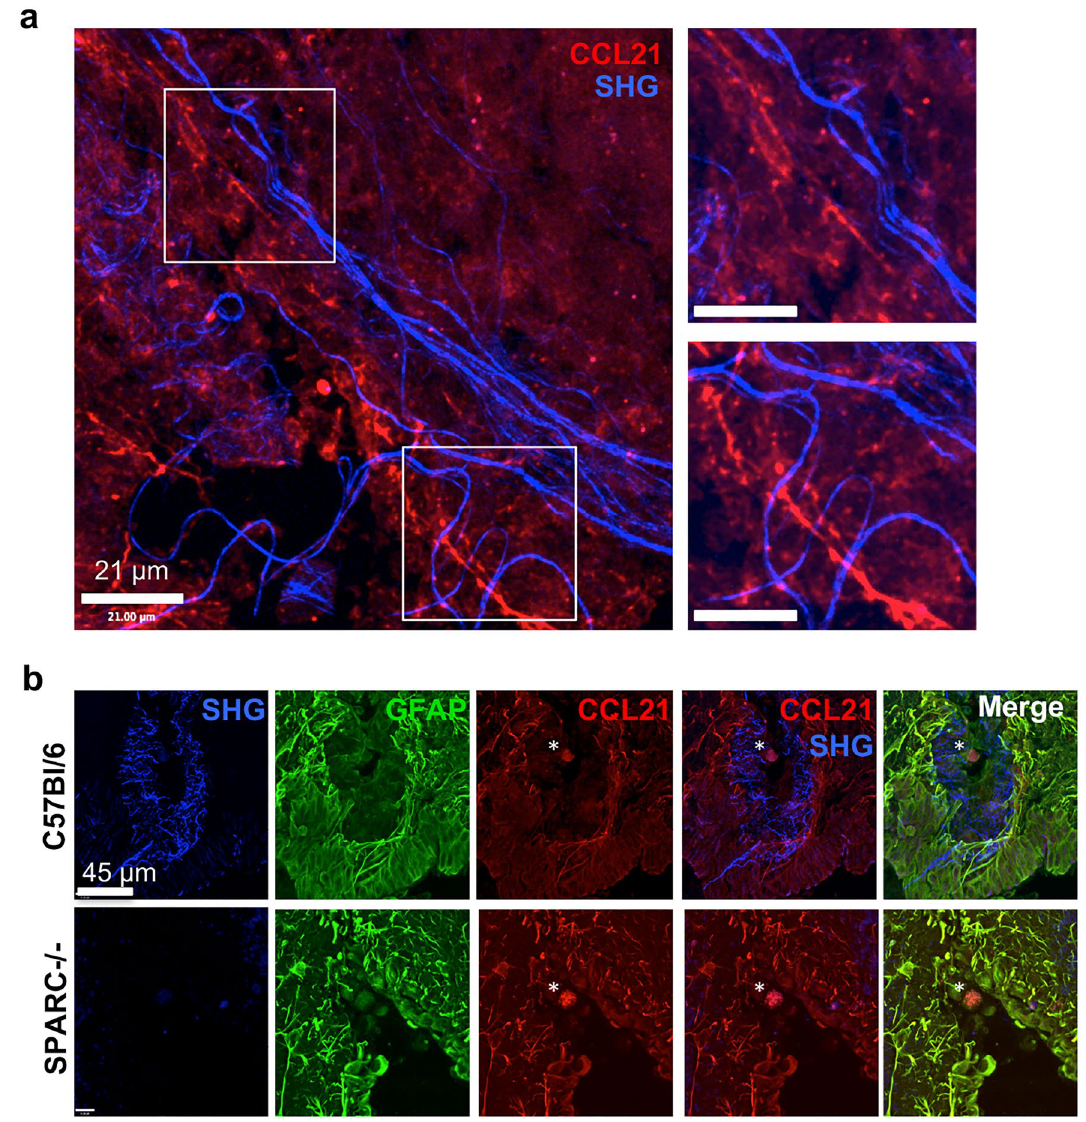
Figure 6. CCL21 and SHG are distinct. Flash frozen C57Bl/6 and SPARC−/− tissue sections from mice infected for 21 days were stained and imaged using multiphoton microscopy to visualize second harmonic signals found in layers 5/6 in the cortex. ( a ) CCL21 (red) SHG (blue). Insets depict SHG parallel to (top) or wrapped around (bottom) strands of CCL21. ( b ) CCL21-stained sections were counterstained with GFAP. Images are representative of 2 individual experiments where n = 3 mice per